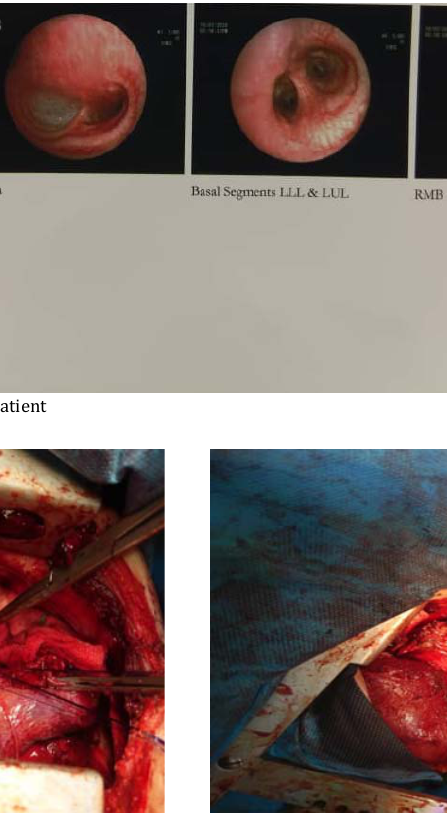
Figure 3. Intra-operative view of bronchial anastomosis Figure 4. Intra-operative view of lung ventilation